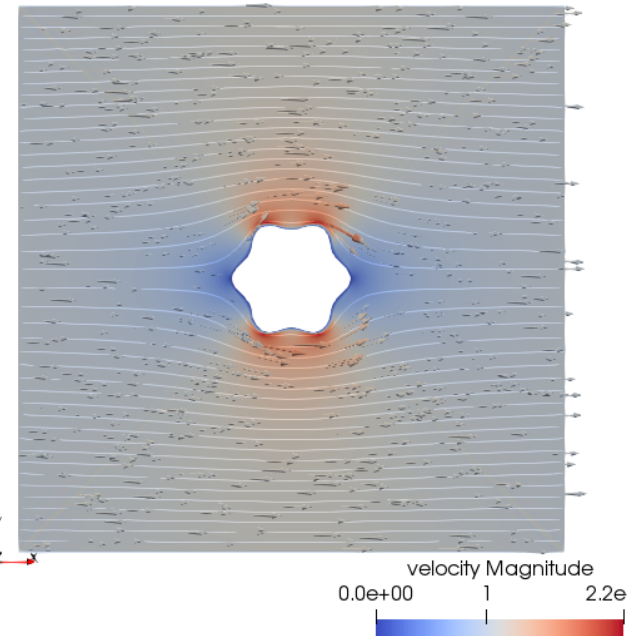
Figure 16. Case 2: the velocity representation with stream lines.